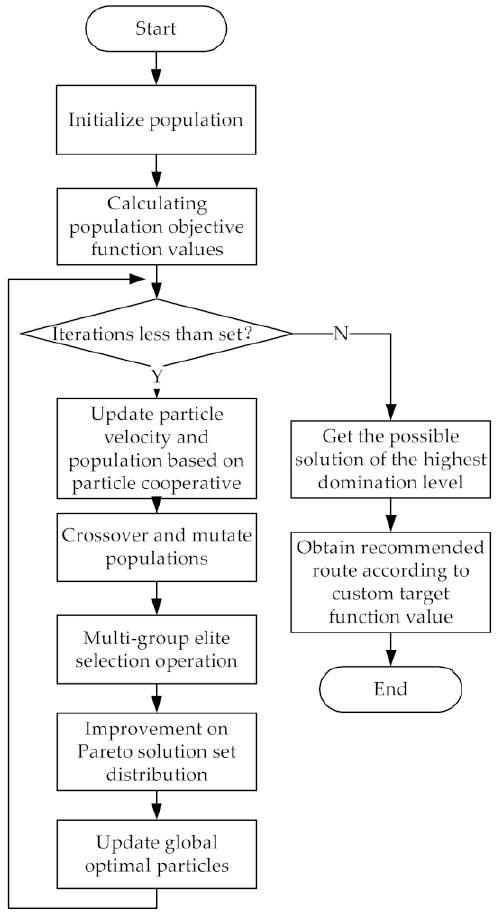
Figure 4. Flow chart of the multicriteria route planning